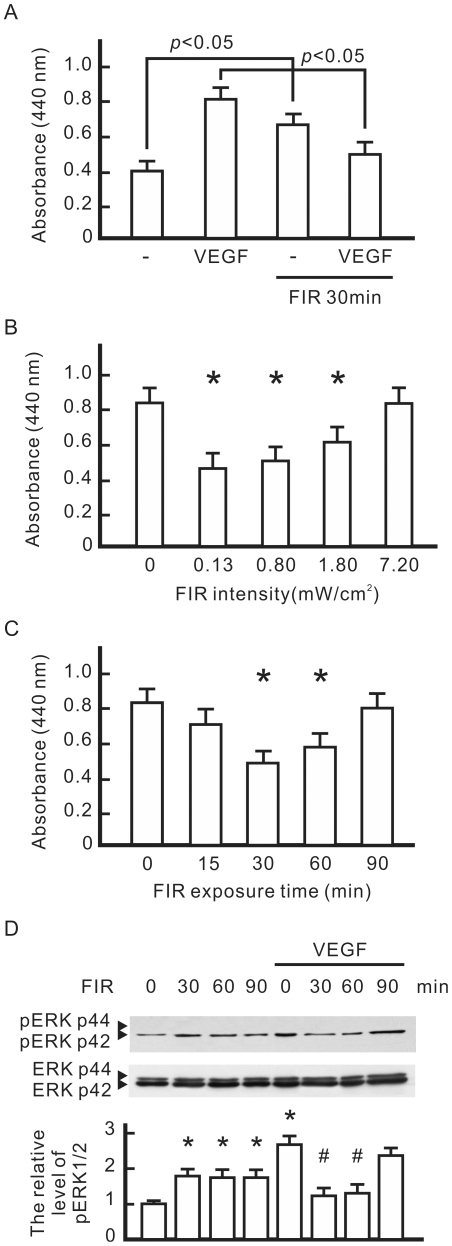
The influence of far infrared (FIR) exposure on VEGF-induced proliferation in HUVECs.(A) The influence of VEGF and FIR on cell proliferation. HUVECs were pretreated with VEGF (10 ng/ml) with or without FIR exposure at 0.13 mW/cm2 for 30 min, and then cultured overnight. Cell proliferation results are presented as the absorbance of each sample at 440 nm. (B) The influence of FIR intensity on VEGF-induced cell proliferation. VEGF-pretreated cells were exposed to FIR at the indicated intensity for 30 min, and then cultured overnight. *p<0.05 vs. the control without FIR exposure. (C) The influence of FIR exposure time on VEGF-induced cell proliferation. VEGF-pretreated cells were exposed to FIR at 0.13 mW/cm2 for the indicated periods, and then cultured overnight. *p<0.05 vs. the control without FIR exposure. (D) Western blotting of VEGF-induced phosphorylation of ERK1/2. HUVECs were pretreated with or without VEGF (10 ng/ml) for 30 min, exposed to FIR at 0.13 mW/cm2 for the indicated periods, and then cultured for 8 h. ERK1/2 was detected as a loading control. By comparison with the control without FIR exposure, the relative levels of phospho-ERK1/2 were obtained and are shown as the mean±S.D. from six determinations in three cell preparations. *p<0.05 vs. the control without FIR exposure. #
p<0.05 vs. the VEGF-treated group without FIR exposure.